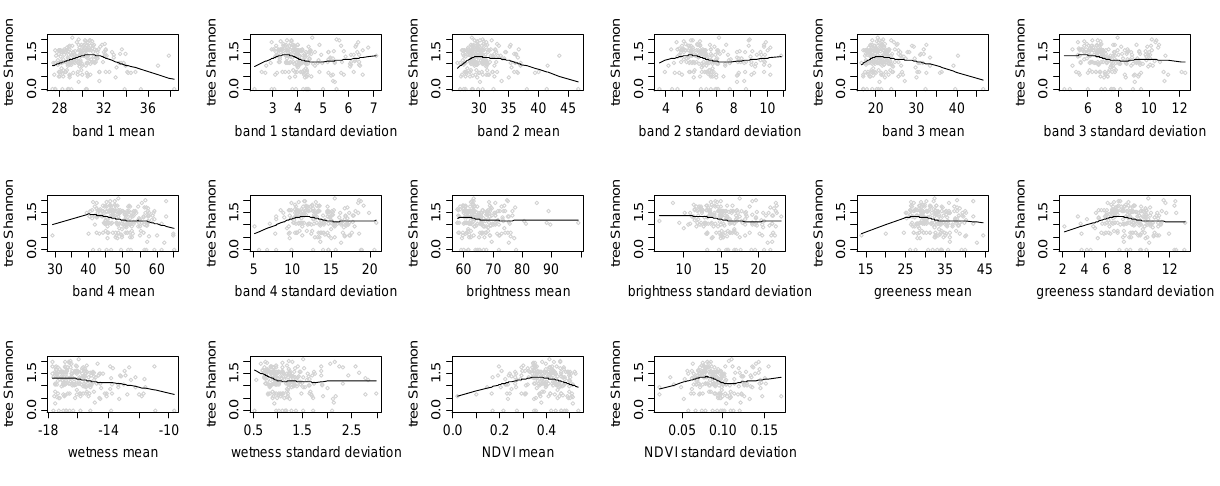
Figure 9. Scatterplots of the number of trees vs. IKONOS spectral variables. Fitted curves represent LOWESS based